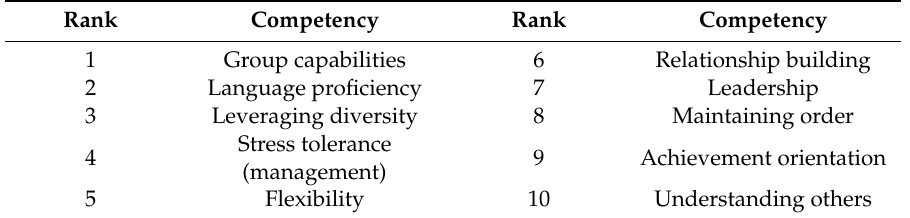
Figure 2. Project managers’ subgroup competencies sorted according to their importance (current state). Table 7. The ranking of core competencies of project managers in collaborative construction projects in the target state.